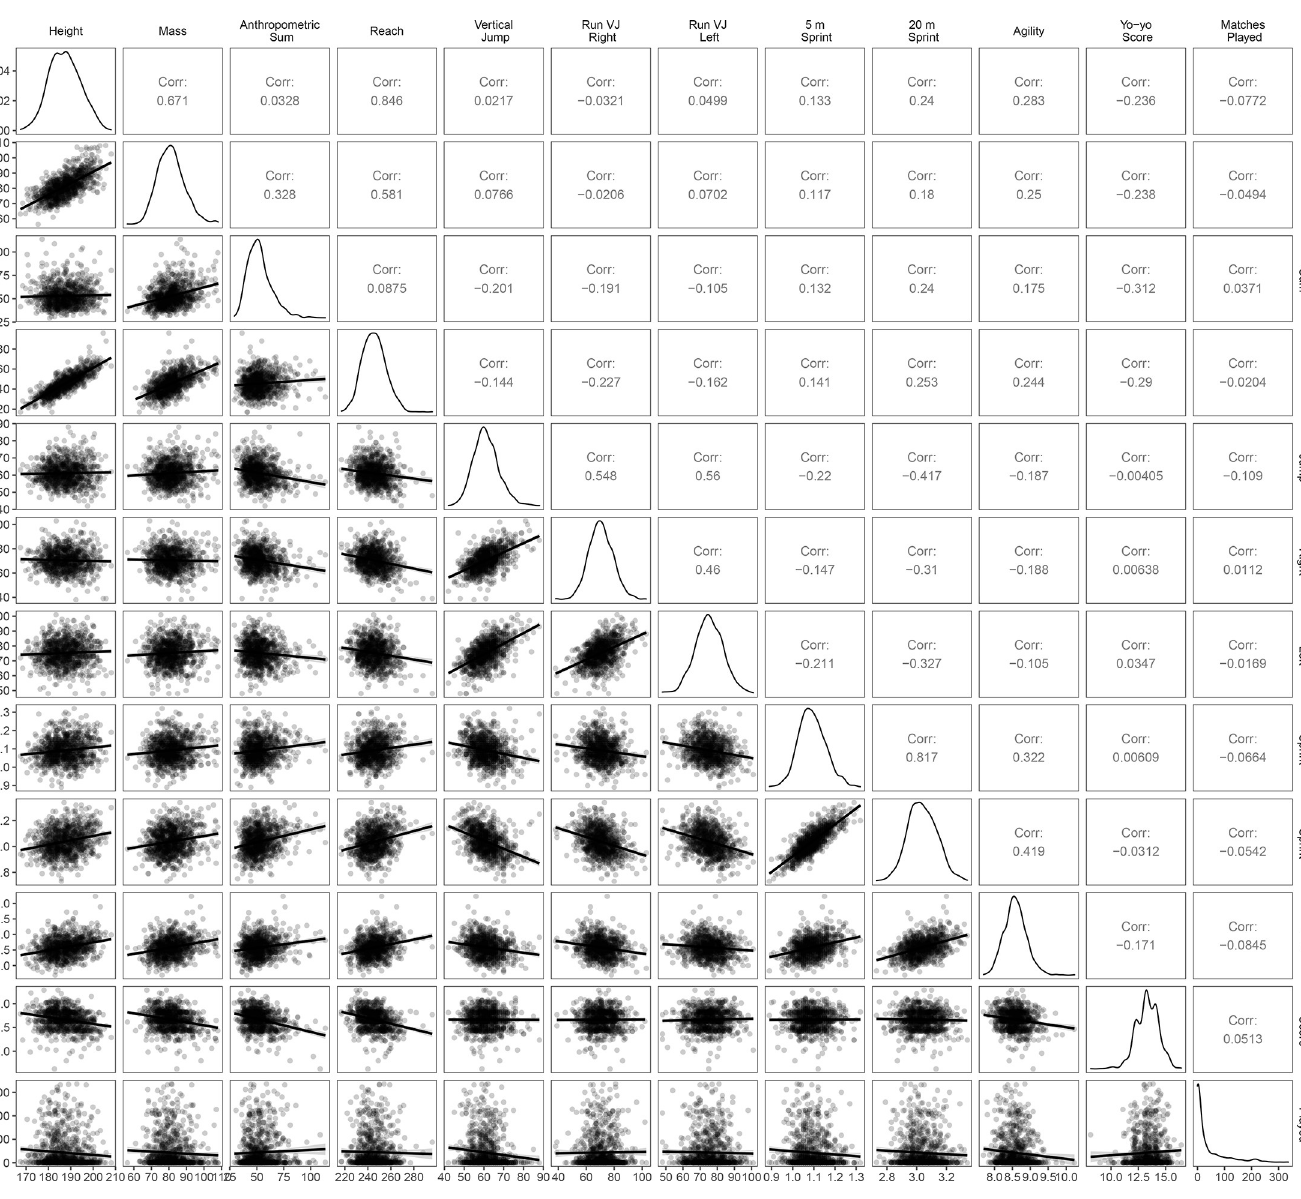
Fig 2. Correlations of anthropometric measures, draft combine performance and matches played.